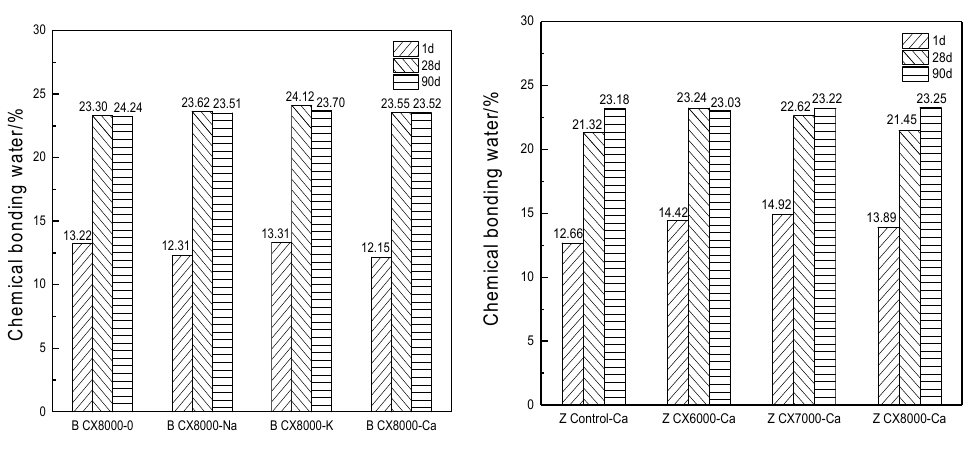
( b ) Chemical-bonded water content in ultrafine cement system at different ages. Figure 6. CH and chemical-bonded water content in ultrafine cement system. Figure 6. CH and chemical-bonded water content in ultrafine cement